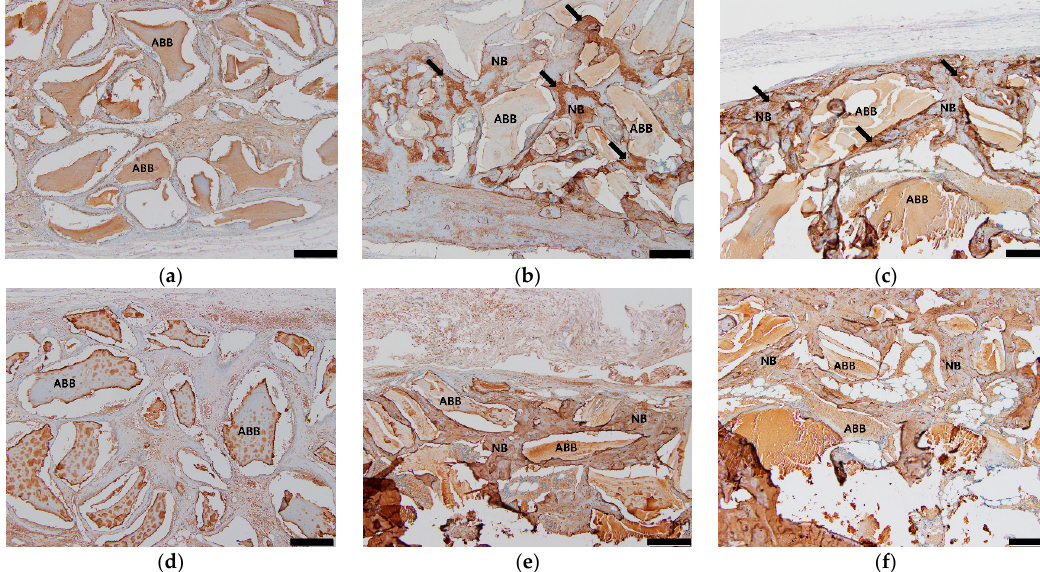
Figure 5. Immunohistochemical staining of bone sialoprotein (BSP; a – c ) and osteocalcin ( d – f ) at 6 weeks after operation. ( a , d ) Control group, ( b , e ) ABB/low BMP, and ( c , f ) ABB/high BMP. A high expression of BSP and osteocalcin (black arrows) was observed in the new bone matrix of the ABB/low and high BMP groups (original magnification 100×, bar = 200 µm). ABB: anorganic bovine bone, NB: new bone.